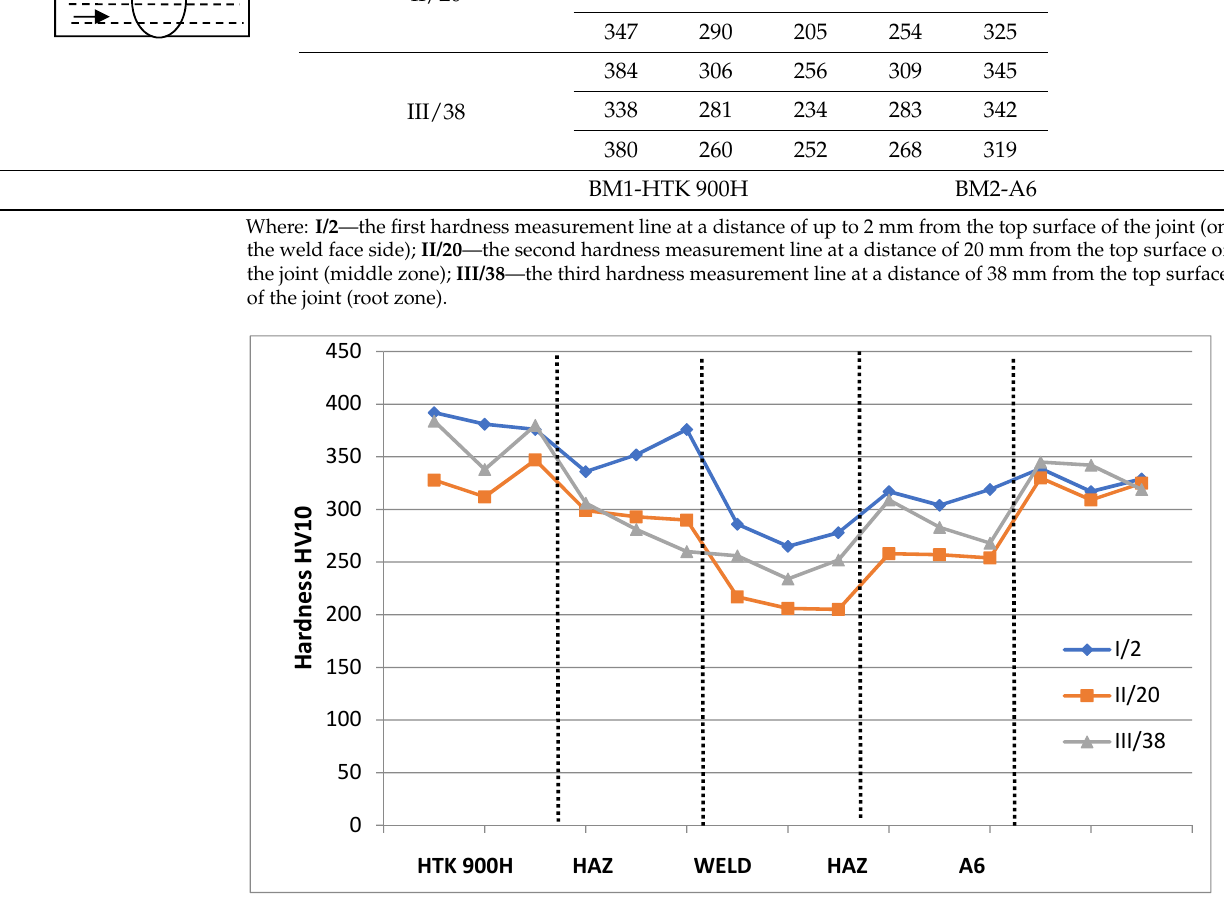
Figure 3. Hardness distribution on the cross-section of the welded joint.